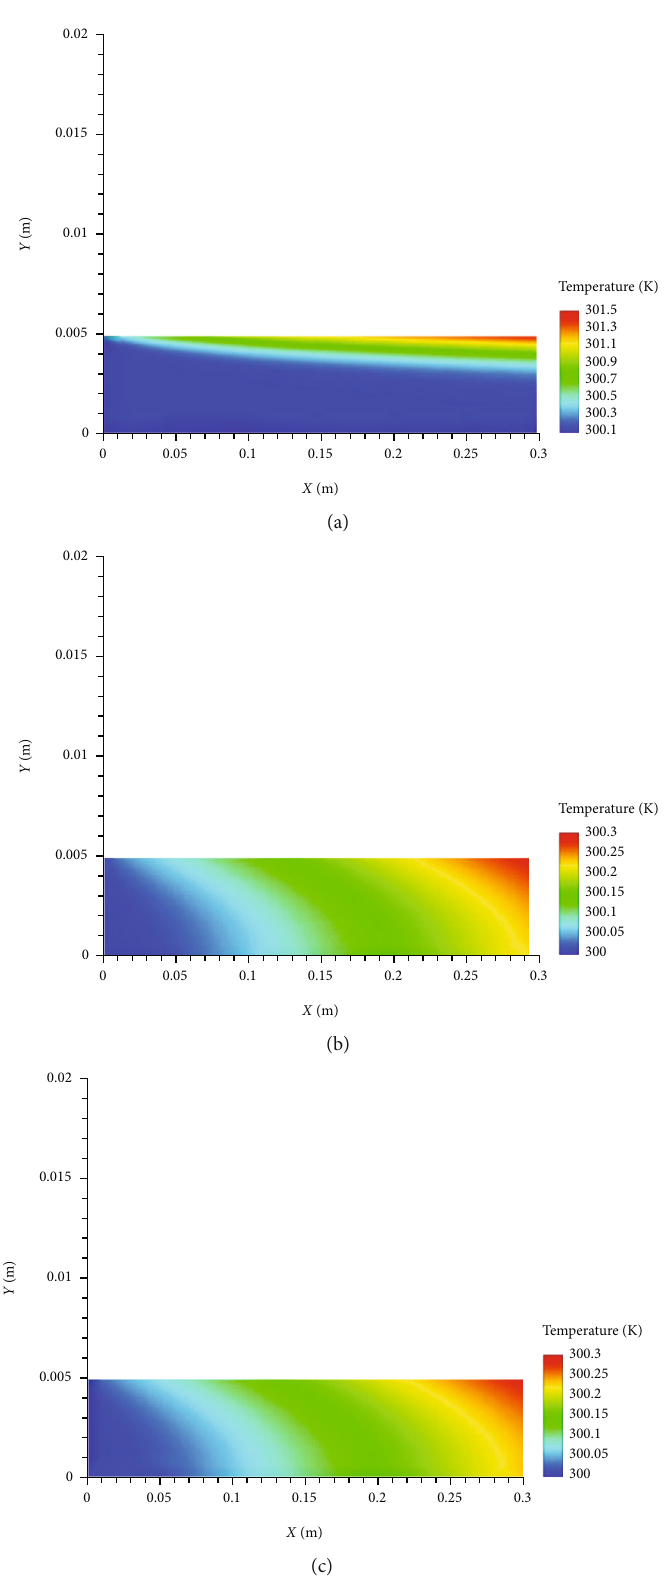
Figure 13: (a) Temperature contour for di ff erent Darcy and Hartmann numbers for water and nano fl uid 0.2% ( Da = 0, Ha = 0 ). (b) Temperature contour for di ff erent Darcy and Hartmann numbers for water and nano fl uid 0.2% ( Da = 0 : 1, Ha = 0 ). (c) Temperature contour for di ff erent Darcy and Hartmann numbers for water and nano fl uid 0.2% ( Da = 0 : 1, Ha = 40